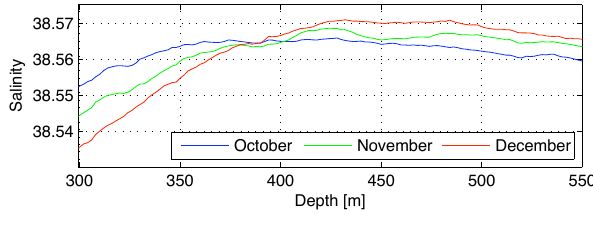
Fig. 10. Climatological Dyfamed salinity profile in the intermediate layer for October, November and December. Fig. 2. Time evolution of LIW characteristics in the Sicily Channel. (a) Potential Temperature and (b) Salinity. LIW characteristics are computed averaging over a water column of 100m. Bar indicates the standard deviation. (updated from Figure 3 in Gasparini et al., 2005). The current, flowing almost permanently from the Tyrrhenian to the Ligurian Sea, has a clear seasonal cycle, with high values in winter and almost negligible values in summer (Figure 3). The seasonal cycle is quite regular and explains a large percentage of the observed variability. The interannual variability related to the winter periods (the colder the winter, the higher the transport) is remarkable: the higher transports observed during the 1980s were significantly reduced during the 1990s.